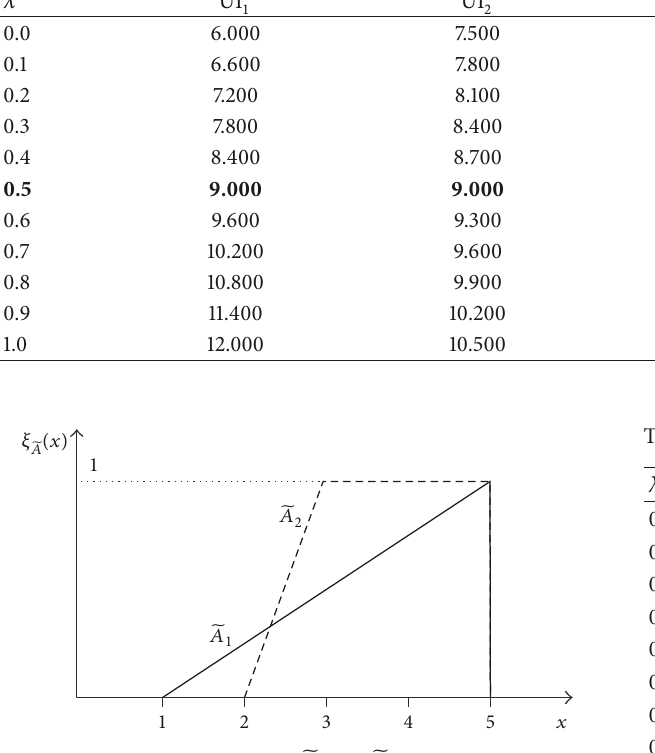
Figure 6: Fuzzy numbers